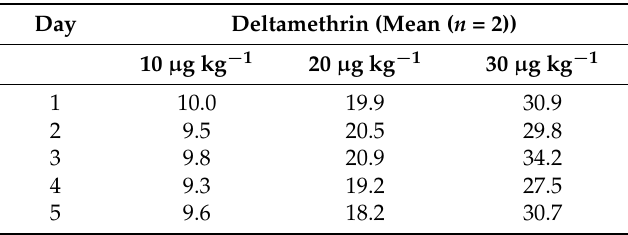
Table 3. Inter-assay variations (%) in goat milk samples ( n = 2, spiking at 10, 20 and 30 µ g kg − 1 ).